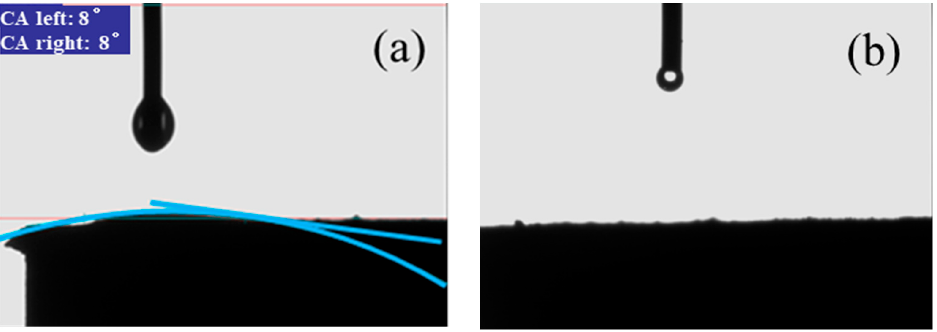
Figure 5. Images of contact angle of ( a ) MCB and ( b ) Ce-MCB in deionized water. FTIR measurements were performed on MCB and Ce-MCB to characterize the func- tional groups present on the adsorbent surface, which were essential for the absorption process of metal ions. As shown in Figure 6, several peaks were observed in the spectra at about 3440, 1610, 1350, and 1070 cm − 1 . The bands at about 3440 cm − 1 and 1350 cm − 1 indicated -OH asymmetric stretching vibration. In the aqueous environment, Ce 3+ can be used as active sites for the dissociation of H 2 O to form -OH [46]. The bands of 1610 cm − 1 could be attributable to C=O (COO − ) stretching and bending vibrations [47]. The 1070 cm − 1 band corresponded to the vibration of C-O. The peaks of carboxyl and hydroxyl groups were greatly enhanced after Ce(NO 3 ) 3 modification, which facilitates the absorption of heavy metals. The FTIR analysis results were in agreement with RS as well as contact angle results.